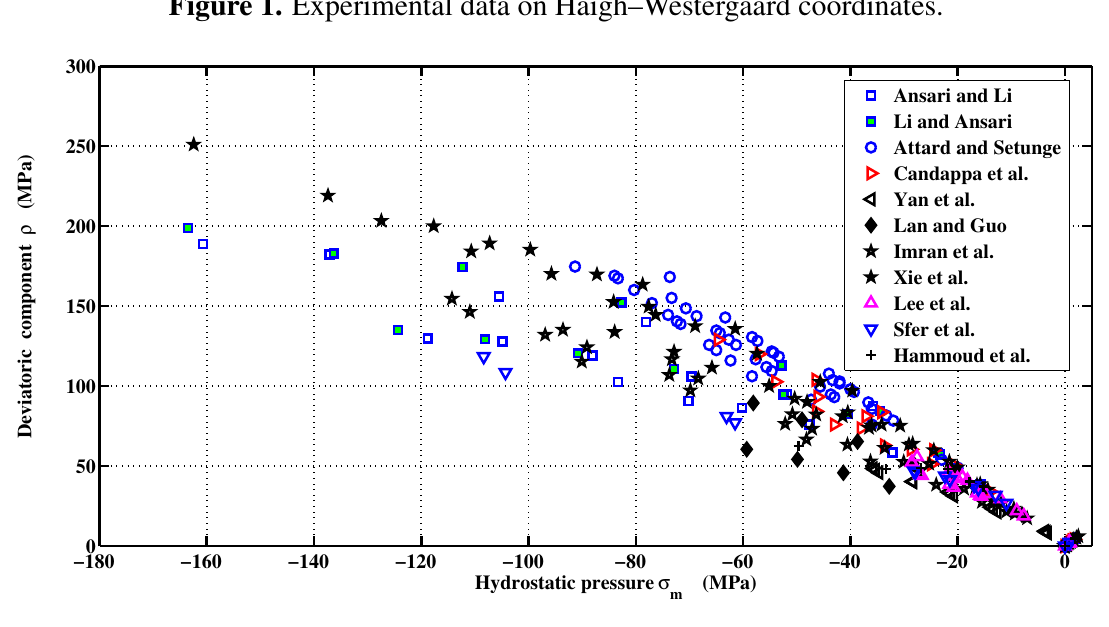
Figure 1. Experimental data on Haigh–Westergaard